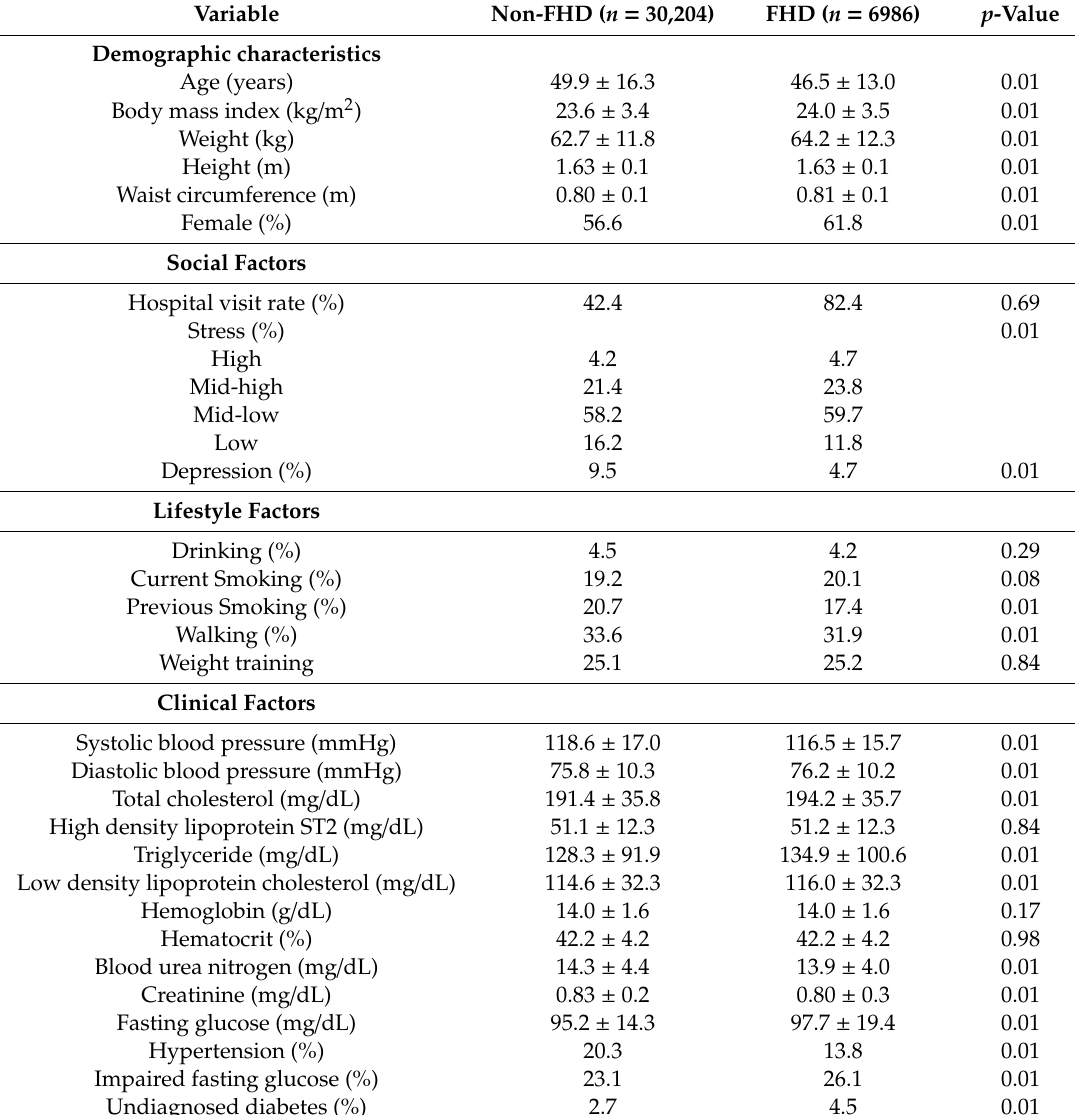
Table 1. Baseline characteristics of people with FHD and without